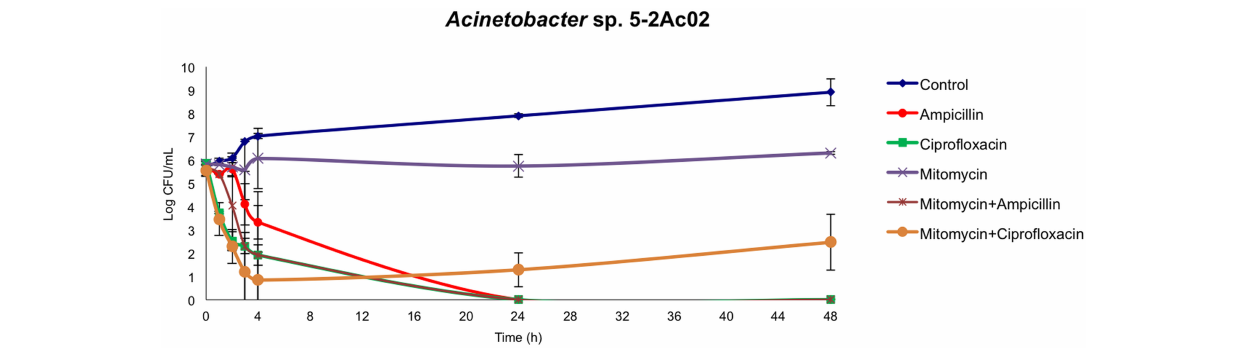
Frontiers in Microbiology |